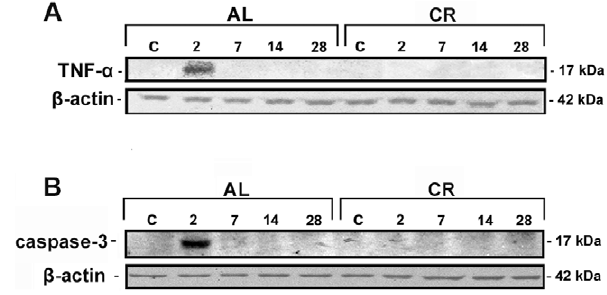
Figure 3. CR treatment inhibits the induction of soluble TNF- a and active caspase-3. Western blot analysis of the temporal expression of soluble TNF- a (A) and active caspase-3 (B) revealed the induction of both proteins only in the ipsilateral cortex of AL animals on the 2 nd day following injury. Expression of both proteins was not detected in the CR group. Actin bands are the loading control. Representative immunoblots (n=5 animals per experimental group) are presented; c – physiological control; 2, 7, 14, 28 – days following